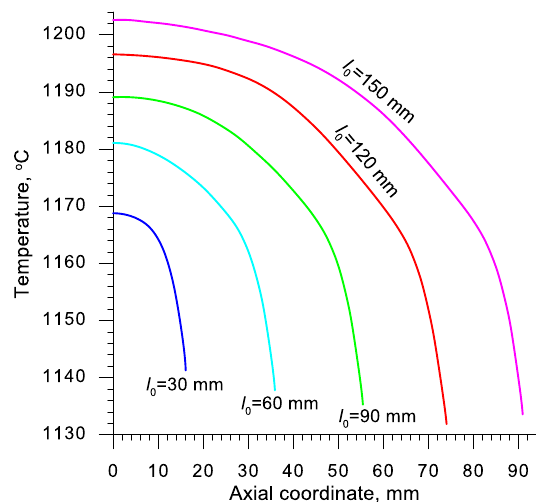
Figure 13. Numerically calculated distribution of temperature in the axis of the sample, heated to 1150 °C and subjected to rotational compression on the path 315 mm; axial ordinate 0 describes the location of the plane of symmetry.